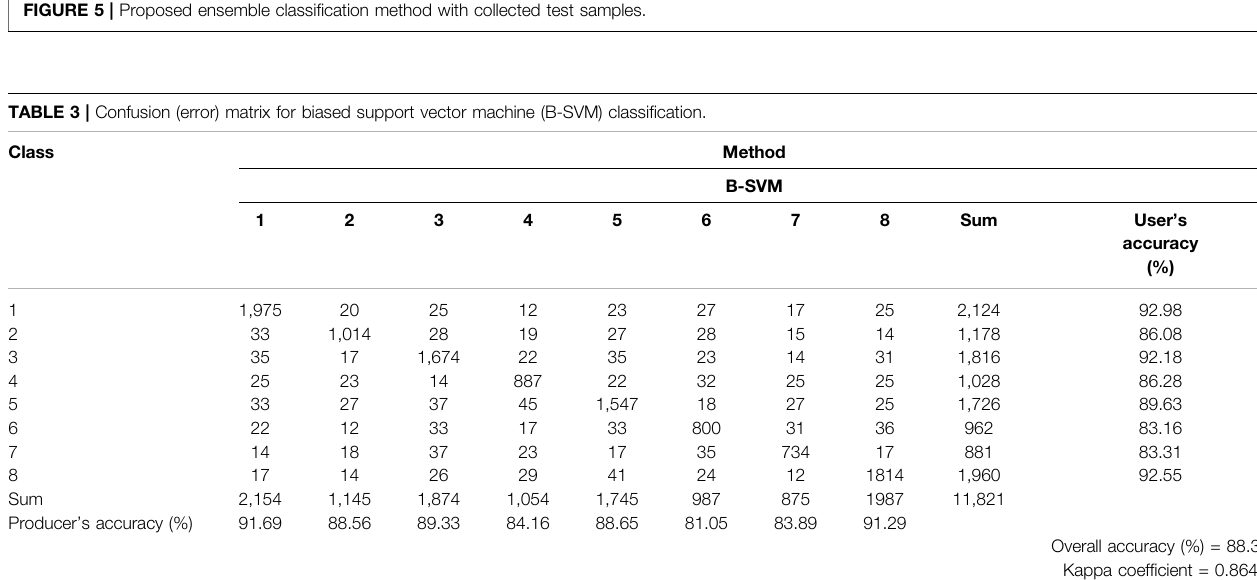
FIGURE 5 | Proposed ensemble classi fi cation method with collected test samples.